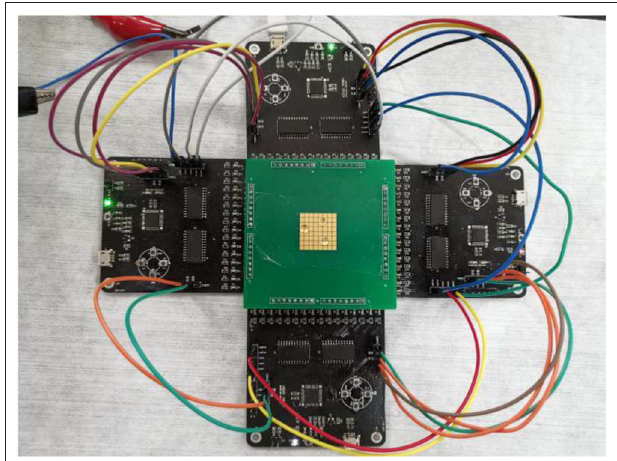
FIGURE 12 | Connection diagram of the EWOD system.